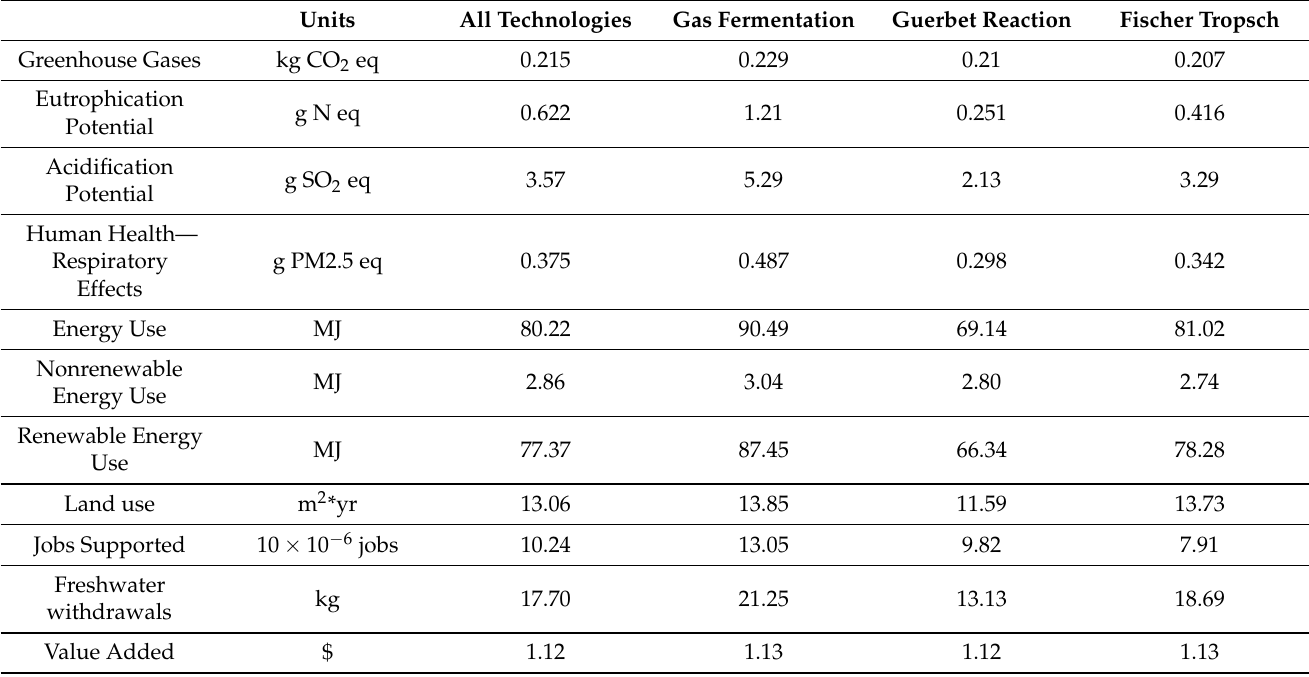
Table 2. Biofuels impacts per GGE with a 3.68%